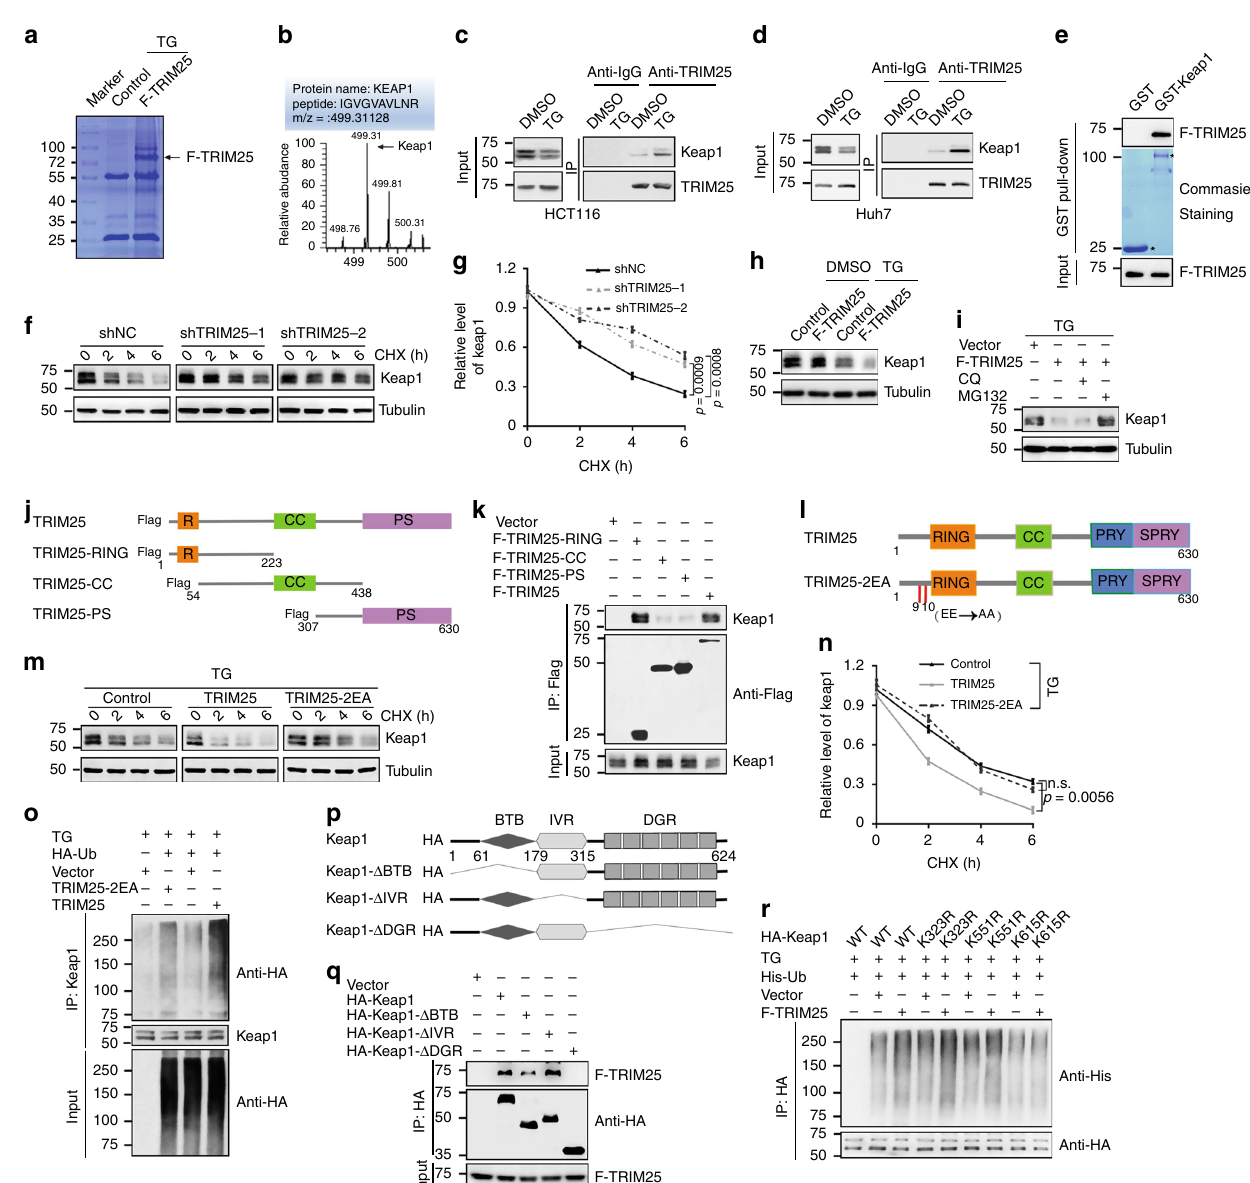
Fig. 3 TRIM25 interacts and ubiquitinates Keap1. a Identi fi cation potential substrates of TRIM25 related to ER stress by liquid chromatography-tandem mass spectrometry. b The Keap1 peptides identi fi ed through mass spectrometry are shown. c , d Co-immunoprecipitation (co-IP) assay analyzes the interaction of endogenous TRIM25 and Keap1 in HCT116 ( c ) and Huh7 ( d ) cells, treated with or without TG (1 μ M) for 12 h. e In vitro GST pulldown assay analysis of the interaction of TRIM25 (F-TRIM25). Asterisks indicate the coomassie blue staining of GST and GST-Keap1. f , g HCT116 cells infected with shRNA lentivirus as indicated with treatment of TG (1 μ M) for 6 h and then treated with CHX. Representative western blot ( f ) and the corresponding quanti fi ed graph ( g ) are shown. h , i Western blot analysis the level of Keap1 in HCT116 cells treated with or without TG (1 μ M) for 12 h ( h ), and the above cells treated with TG (1 μ M) simultaneously with MG132 (4 μ M) or CQ (50 μ M) for 12 h ( i ). j The RING zinc- fi nger (R), B-Box, coiled-coil (CC) and PRY/ SPRY (PS) domain of TRIM25 are indicated. k Huh7 cells overexpressing full-length and TRIM25 truncates were immunoprecipitated with the indicated antibody. l TRIM25 and its mutant (TRIM25-2EA), the conserved Glu9 and Glu10 were mutated to Ala. m , n HCT116 cells overexpressing the indicated constructs with treatment of TG (1 μ M) for 6 h. Representative western blot ( m ) and the corresponding quanti fi ed graph ( n ) are shown. o HCT116 cells transfected with the plasmids as indicated and treated with TG (1 μ M) for 12 h. Immunoblot analysis of the cell lysates and Keap1-IP with the indicated antibodies. p The broad-complex, tramtrack and bric a brac (BTB) domain, intervening region (IVR) and the double glycine repeat (DGR) or Kelch repeat of KEAP1 were indicated. q , r Huh7 cells were transfected with the indicated plasmids. Immunoblot analysis of the HA-IP and cell lysates ( q ), and the ubiquitination of wide-type and Keap1mutaions with the indicated antibodies ( r ). For g and n , data represent the mean ± SEM ( n = 3). Statistical signi fi cance was assessed using two-tailed Student ’ s t -tests. n.s. not signi fi